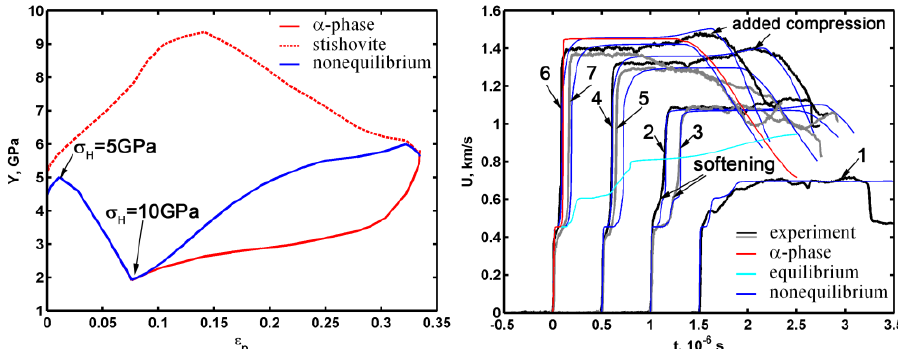
Fig. 2. Yield stress versus plastic strain along the Hugoniot.